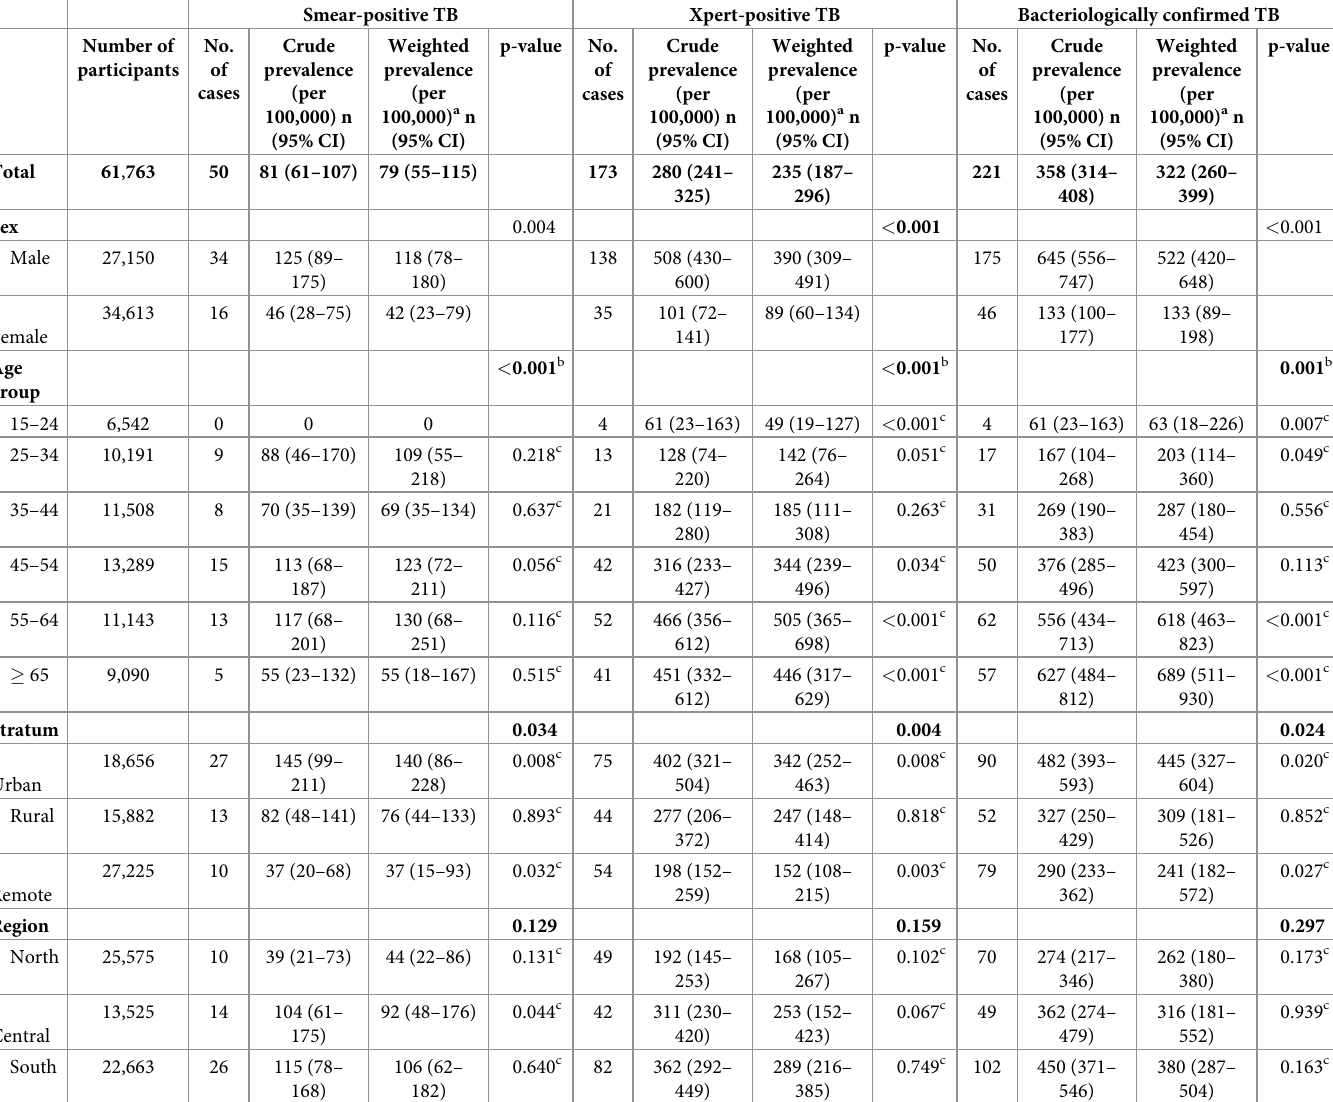
Table 4. Estimated prevalence of pulmonary tuberculosis in Vietnam, overall and by sex, age, area and